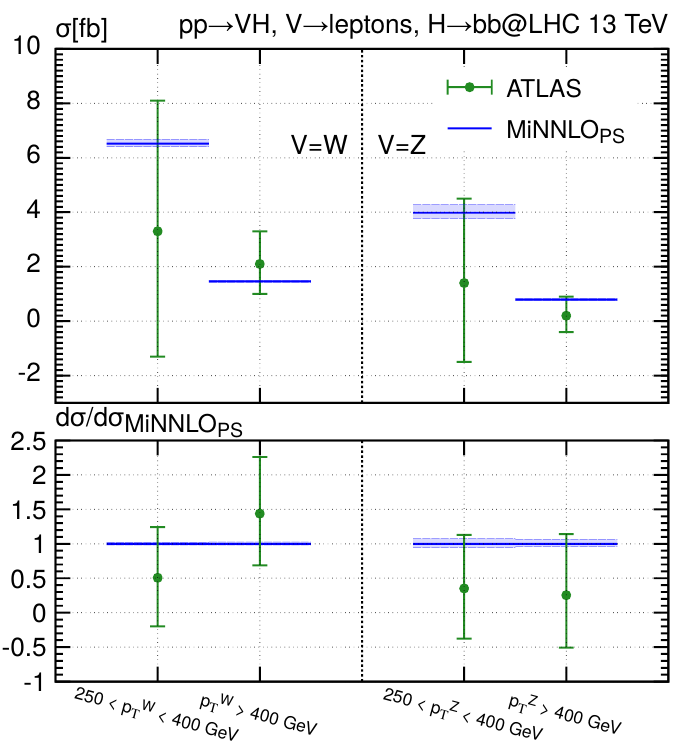
Figure 7 . Comparison of MiNNLO PS predictions to ATLAS data